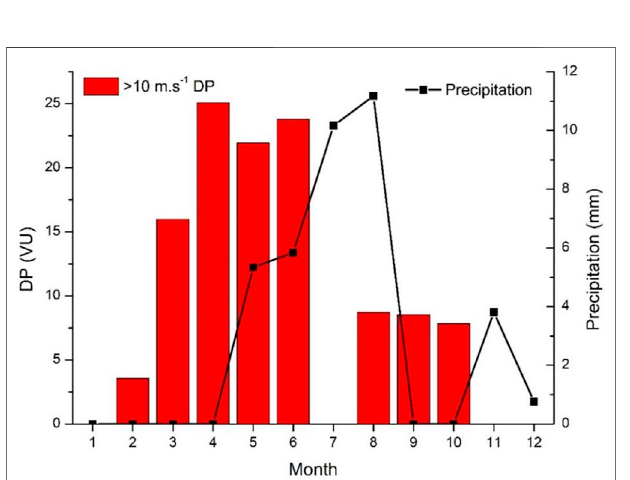
FIGURE 10 | Monthly DP ( > 10 m s − 1 ) and precipitation in the Mogao Grottoes district in 2012. FIGURE11| Thesizecompositionoffallingdustparticlesinthecavesof